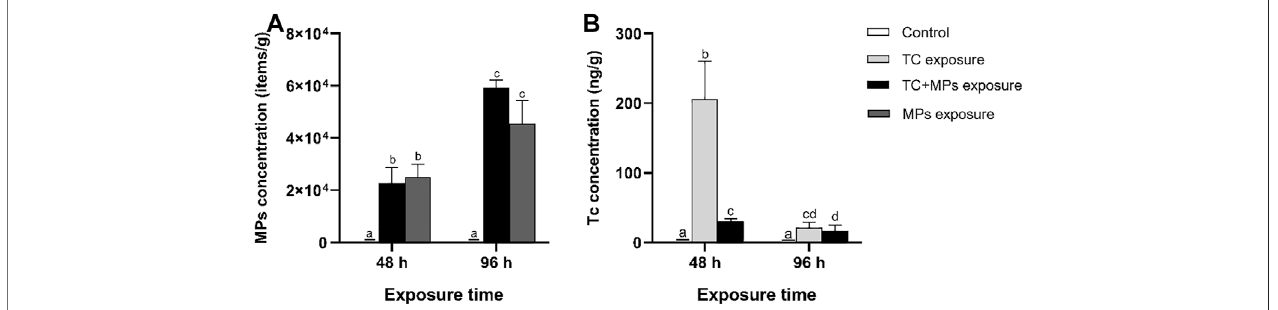
FIGURE 1 | Bar graph presentation of PS-MP concentration (A) and TC concentration (B) variation in intestines of Jian carp treated with various exposure treatments of Control, TC + MP group, and MP group during 48 and 96 h exposure. The values represent mean ± SD of three independent experiments. Different lowercase letters indicate statistically signi fi cant difference between treatments ( p <